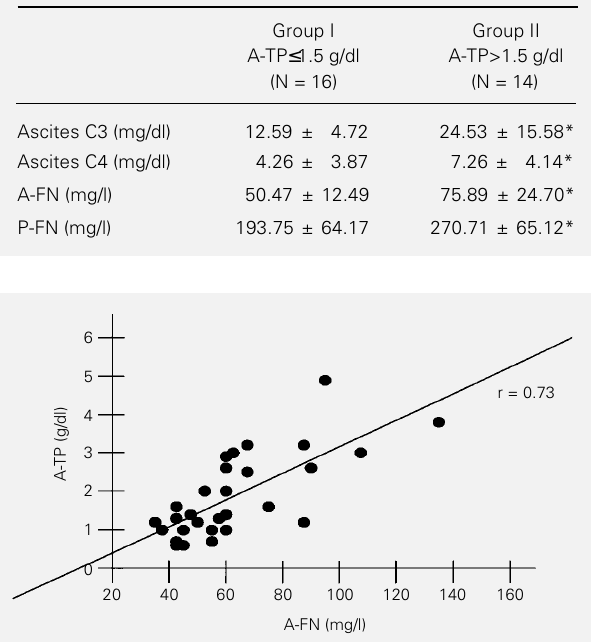
Table 3 - C3, C4, and fibronectin concentration in the ascitic fluid (A- FN) and plasma (P-FN) of patients with liver cirrhosis.